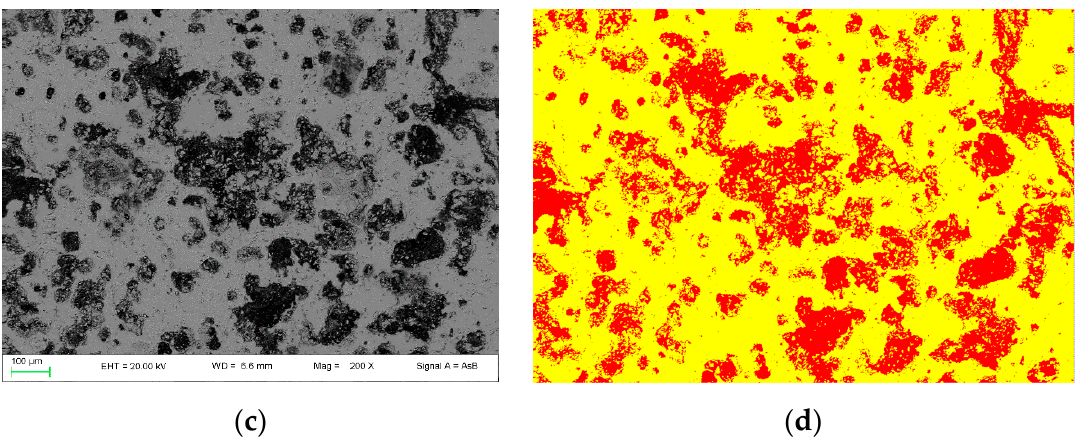
Figure 5. Example of FE-SEM image analysis performed on ( a , b ) the nPC1450d sample and ( c , d ) the PC1450c. The acquired images ( a , c ) are shown together with the processed ones ( b , d ). Samples nPC1450d, nPC1350d, PC1450c, and PC1350c have been characterized by laboratory X-ray µ CT. In Figure 6, examples of reconstructed axial slices after filtering and the corresponding binary images obtained by segmentation are reported. The whole porosities set is evident and their size qualitatively ranges from tens to several hundreds of microns. The 3D renderings of the extracted VOIs is shown in Figure 7 together with the corresponding iso-surfaces of the pore phases.